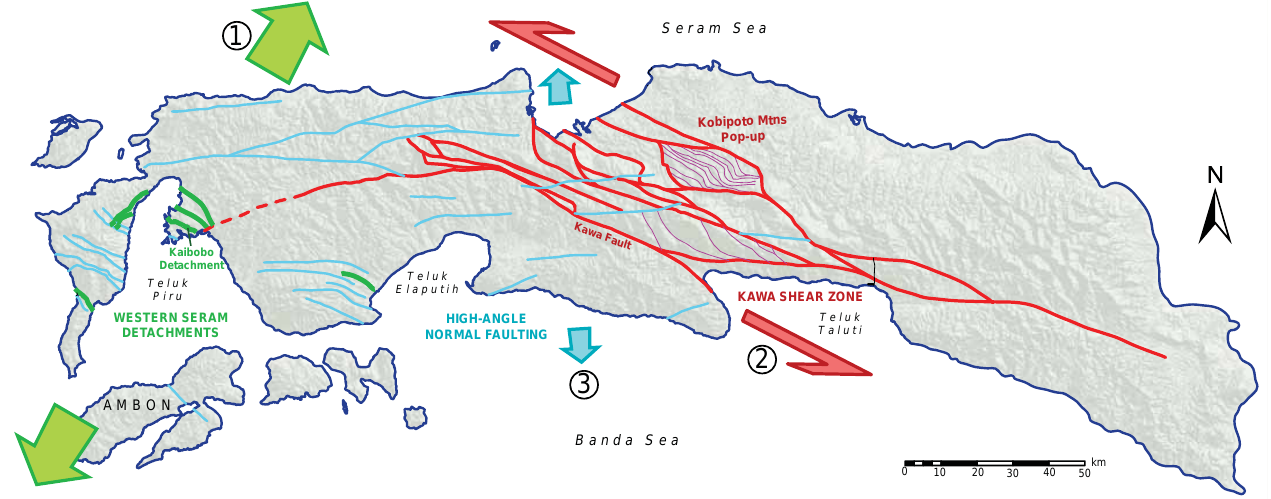
Fig. 20. Structural sketch map of Seram showing detachment faults (green), strike-slip faults (red), high-angle normal faults (blue), and faults within the Kobipoto Mountains strike-slip pop-up structure (magenta) inferred from field observations and DEM interpretation. The relative timings of these three faulting episodes is indicated: Detachment faults strike normal to an inferred NNE–SSW initial extension direction (1); possible subsequent reactivation of detachment faults in central Seram by WNW–ESE left-lateral shear (2) forms the Kawa Shear Zone and Kobipoto Mountains pop-up; late-stage normal faulting in response to slight N–S extension (3) cross-cuts all other structures. The SRTM DEM is used as the base